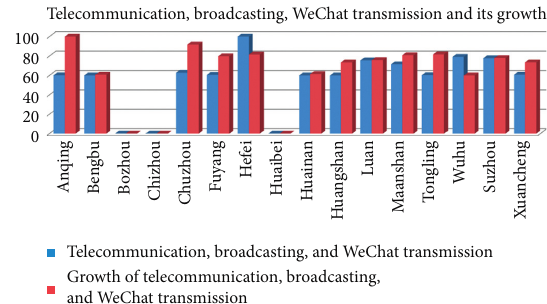
Figure 4: Telecommunication, broadcasting, and WeChat transmission and its